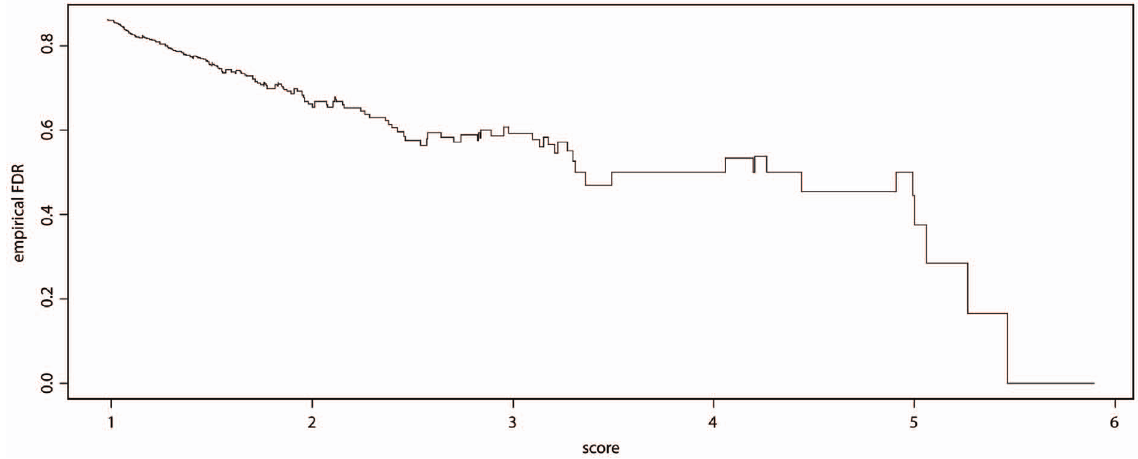
Figure 5. Empirical FDR for calls longer than 6000 base pairs, Hapmap data.